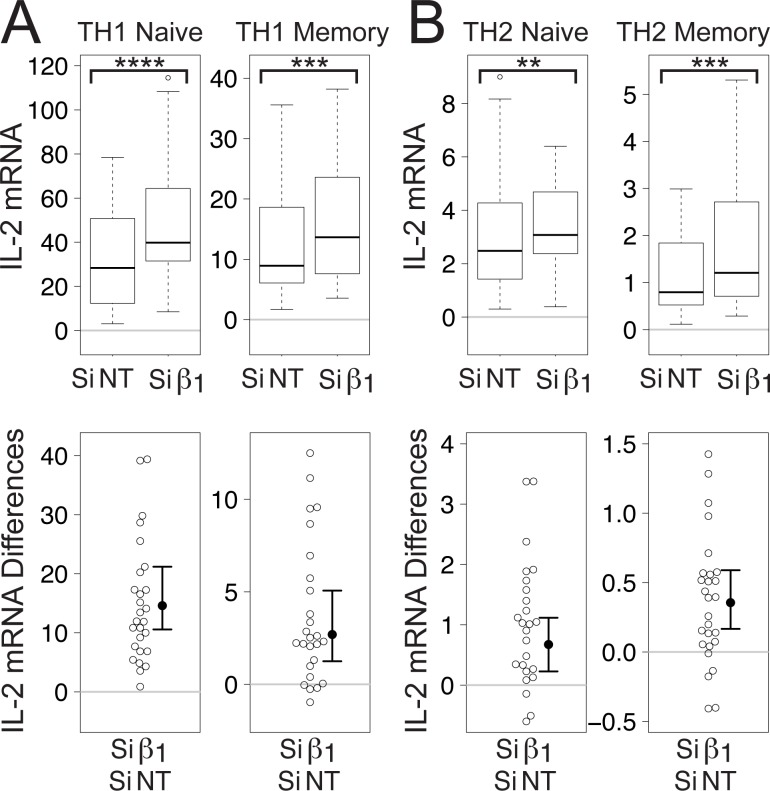
Gβ1 siRNA potentiates TCR-stimulated increases in IL-2 mRNA levels in primary human CD4+ T cells.Box plots (top) and difference plots (bottom) show data from primary human naïve and memory CD4+ T cells isolated from the blood of 30 healthy donors and stimulated for three days with plate-bound anti-CD3 and soluble anti-CD28 in conditions promoting TH1 (A) or TH2 (B) differentiation. IL-2 mRNA levels were determined by qPCR. **, p < 0.01; ***, p < 0.001; ****, p < 0.0001.